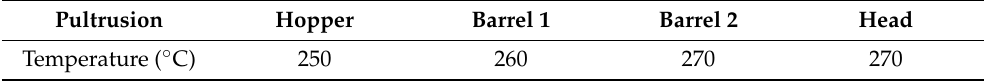
Figure 1. Masterbatch processing schematics of ( a ) the pultrusion process and ( b ) the direct extru- sion process. Table 2. Extruder temperature profile for the LFT pultrusion manufacturing processes.